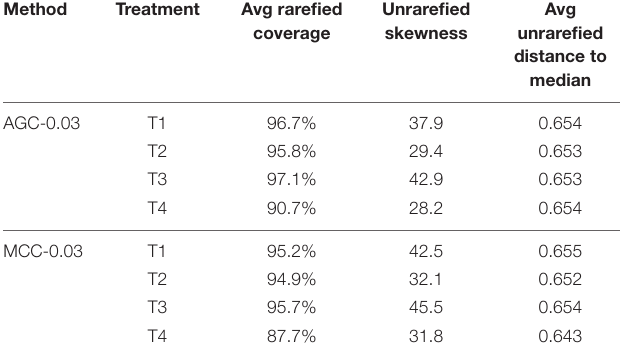
TABLE 2 | nifH OTU table statistics for each agricultural treatment. Method Treatment